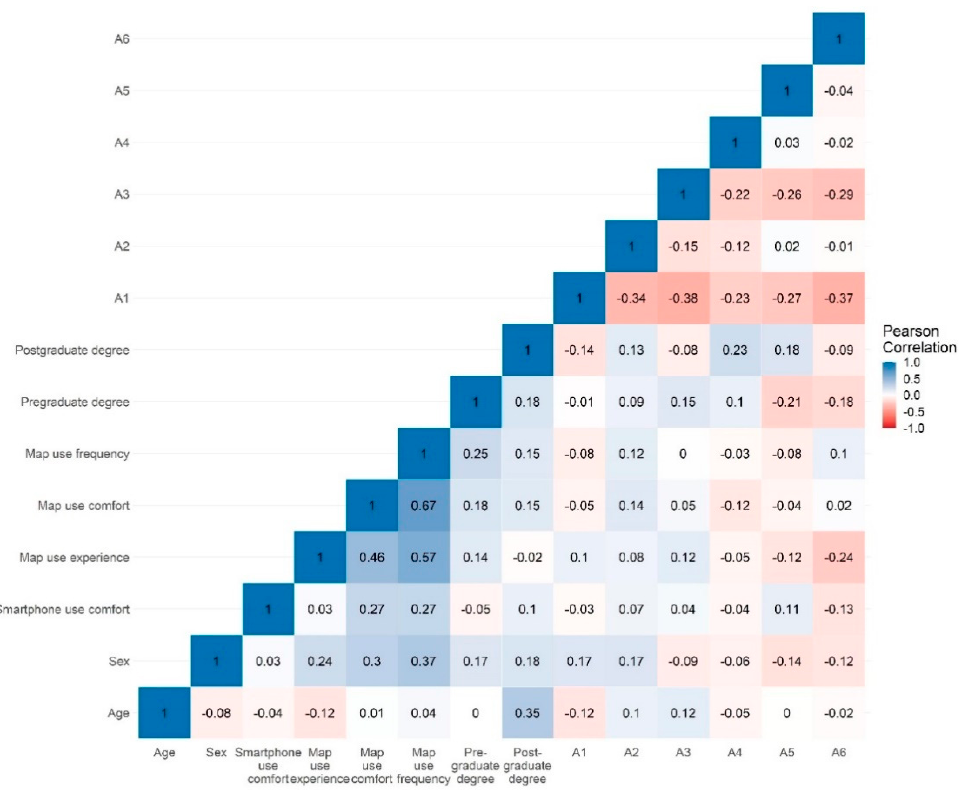
Figure 16. Correlation matrix of participant characteristics and archetypes.